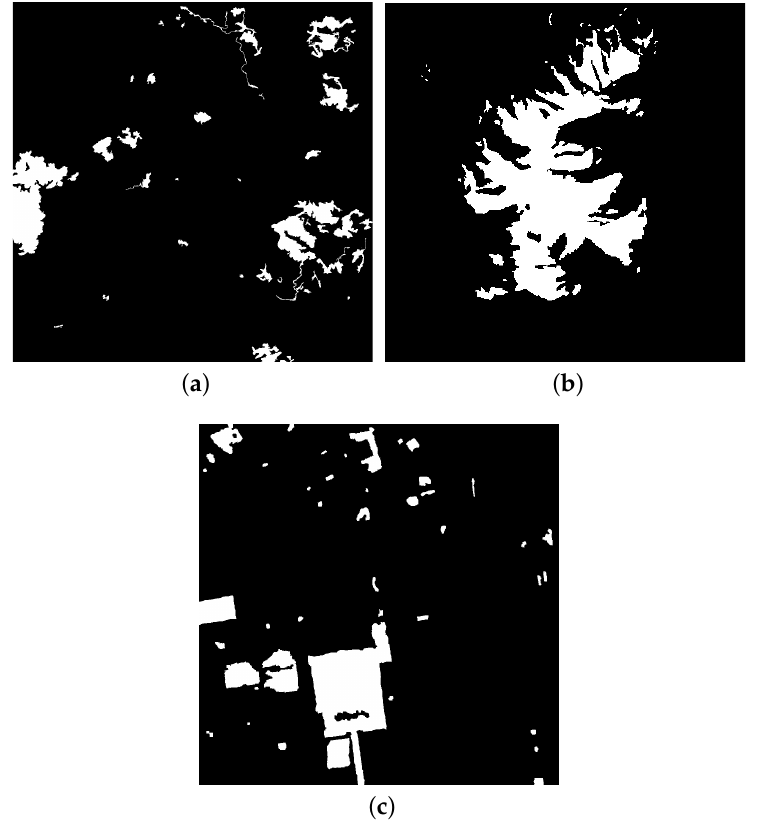
Figure 8. Manually labeled ground truth for three test data sets. ( a ) ground truth map of Hobet (TM); ( b ) ground truth map of Mountain Hiller (ASTER); ( c ) ground truth map of Shijingshan